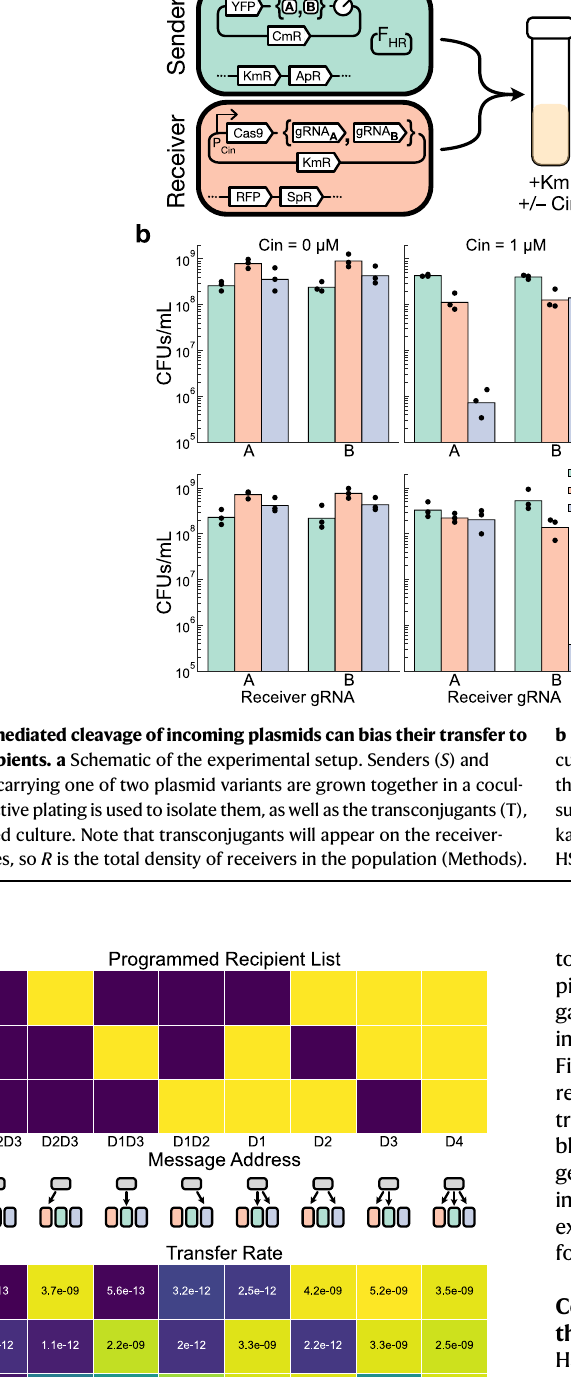
Fig. 4 | Programmable delivery of message plasmids to arbitrary subsets of a multi-strainpopulation.a Schematicrepresentationoftheintendedrecipientlist for each of the eight message plasmids. Dark squares indicate an invalid transfer, and light squares indicate a valid transfer. b The observed geometric mean of the transfer rates to each receiver type, calculated from three biological replicates measured on different days. The color map is scaled logarithmically over four orders of magnitude. Individual transfer rate values are shown in Supplementary Fig. 3. Source data are provided as a Source Data fi